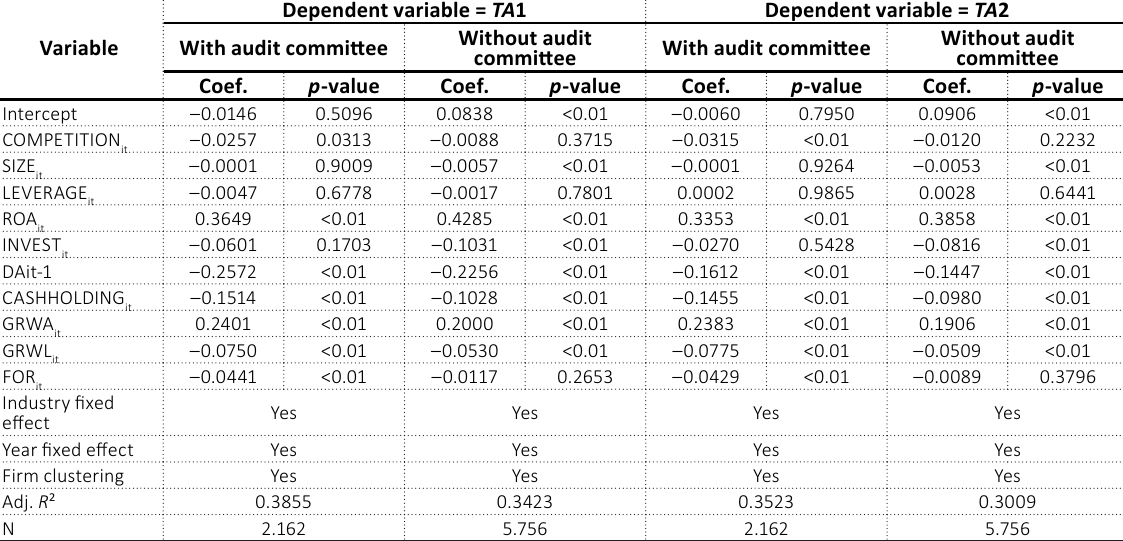
Table 6. The effect of audit committee on the relationship between product market competition